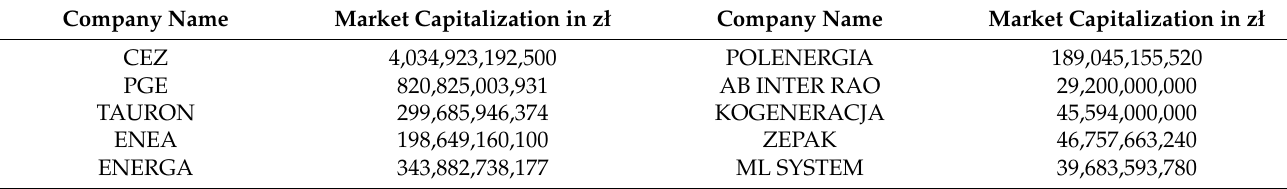
Figure 3. Share of capital groups in the volume of electricity fed into the grid in 2021. Source: author ’ s study based on: https://profit-journal.pl/raport-sektorowy-energetyka/ (access date: 15 August 2021) [60]; bankier.pl (accessed on 23 November 2021). Table 6. Energy groups in the energy sector in